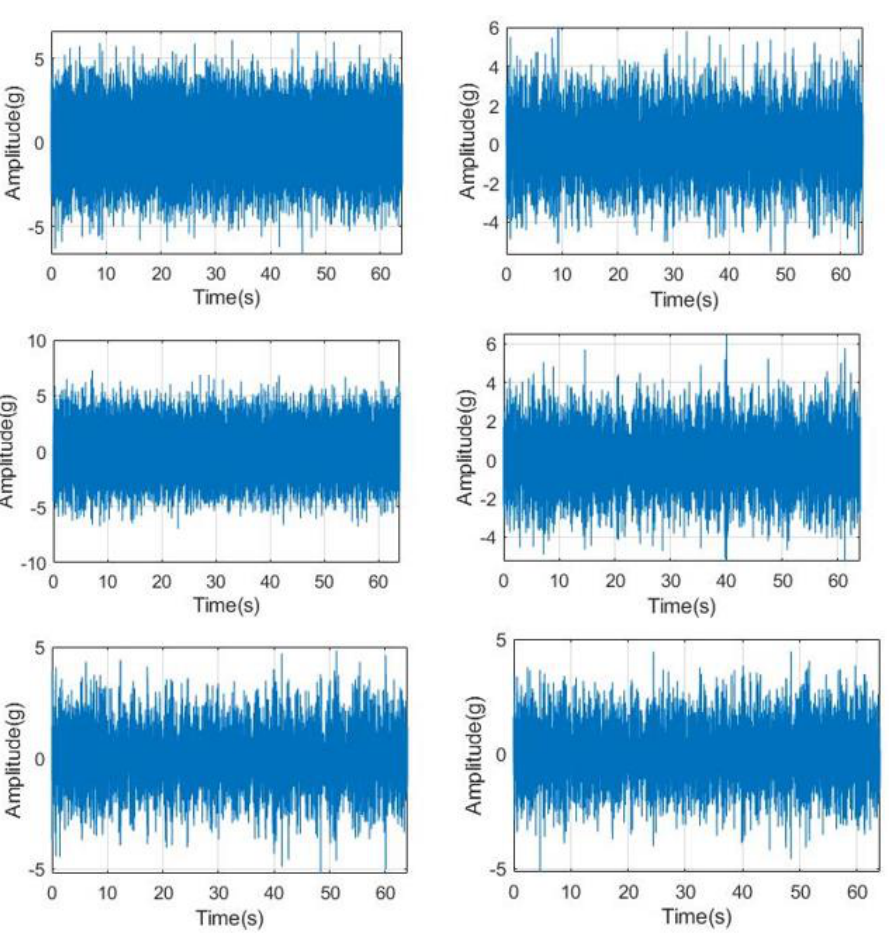
Figure 4. Experimental setup.